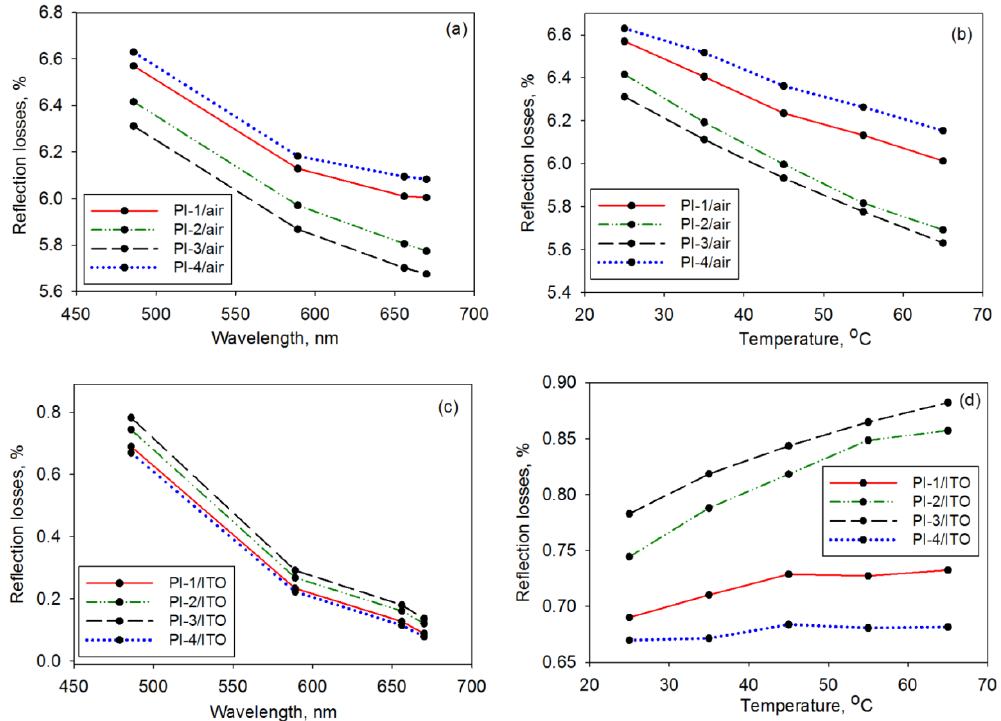
Figure 5. The wavelength and temperature dependence of the reflection losses for the PI-1, PI-2, PI-3, and PI-4 films at ( a , b ) the air interface and ( c , d ) ITO interface.